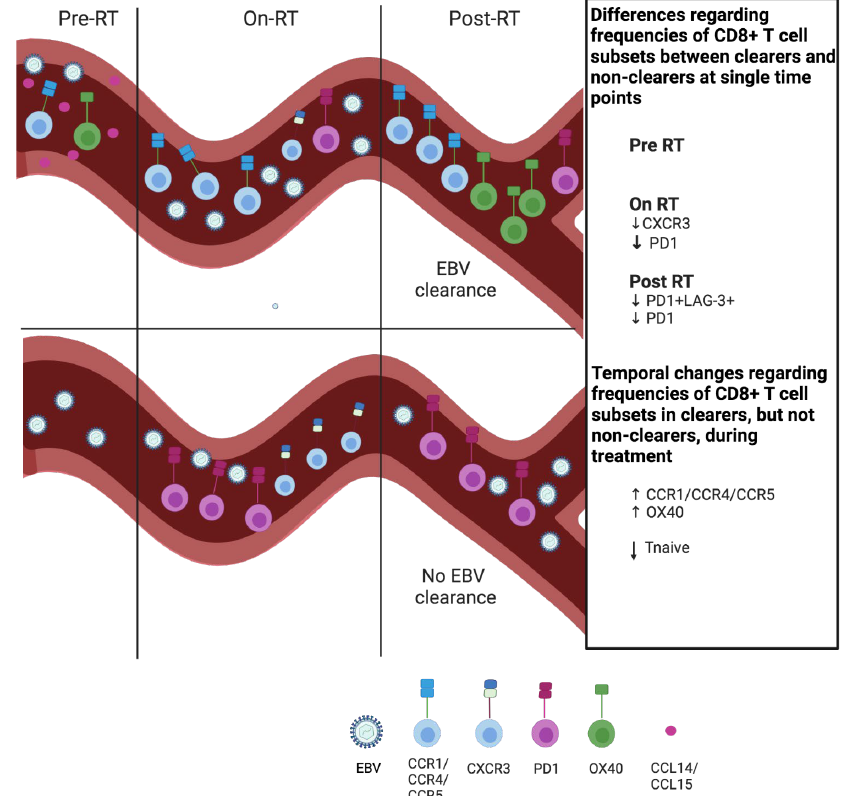
Figure 7: Overview of T cell profiles in blood of NPC patients upon radiotherapy according to Figure 7. Overview of CD8+ T-cell profile in blood of NPC patients upon radiotherapy according to EBV clearance. plasma EBV DNA clearance. Schematic overview of abundances of peripheral CD8+ T-cell